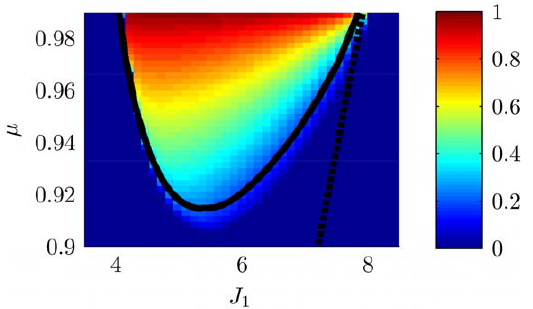
Figure 4. Double ring solutions. Region in the parameter space J 1 , m ð Þ , where the double ring solution c = 0 exists. The color correspond to the value of c which solve Eqs. 8. Due to the symmetry of equations, both positive and negative c values are allowed. Here only the positive solution is shown, corresponding to a localized solution in map B . Black curve: curve of separation between the null and positive c solutions, obtained by finding the zeros of Eq. 12. Note that the method used to obtain the curve is more precise than the one used to estimate c . Dashed curve: curve corresponding to a network activity size s ~ 0 . Regions on the left of this curve have s w 0 , which is a limit size of the double ring solutions (reached at m ~ 1